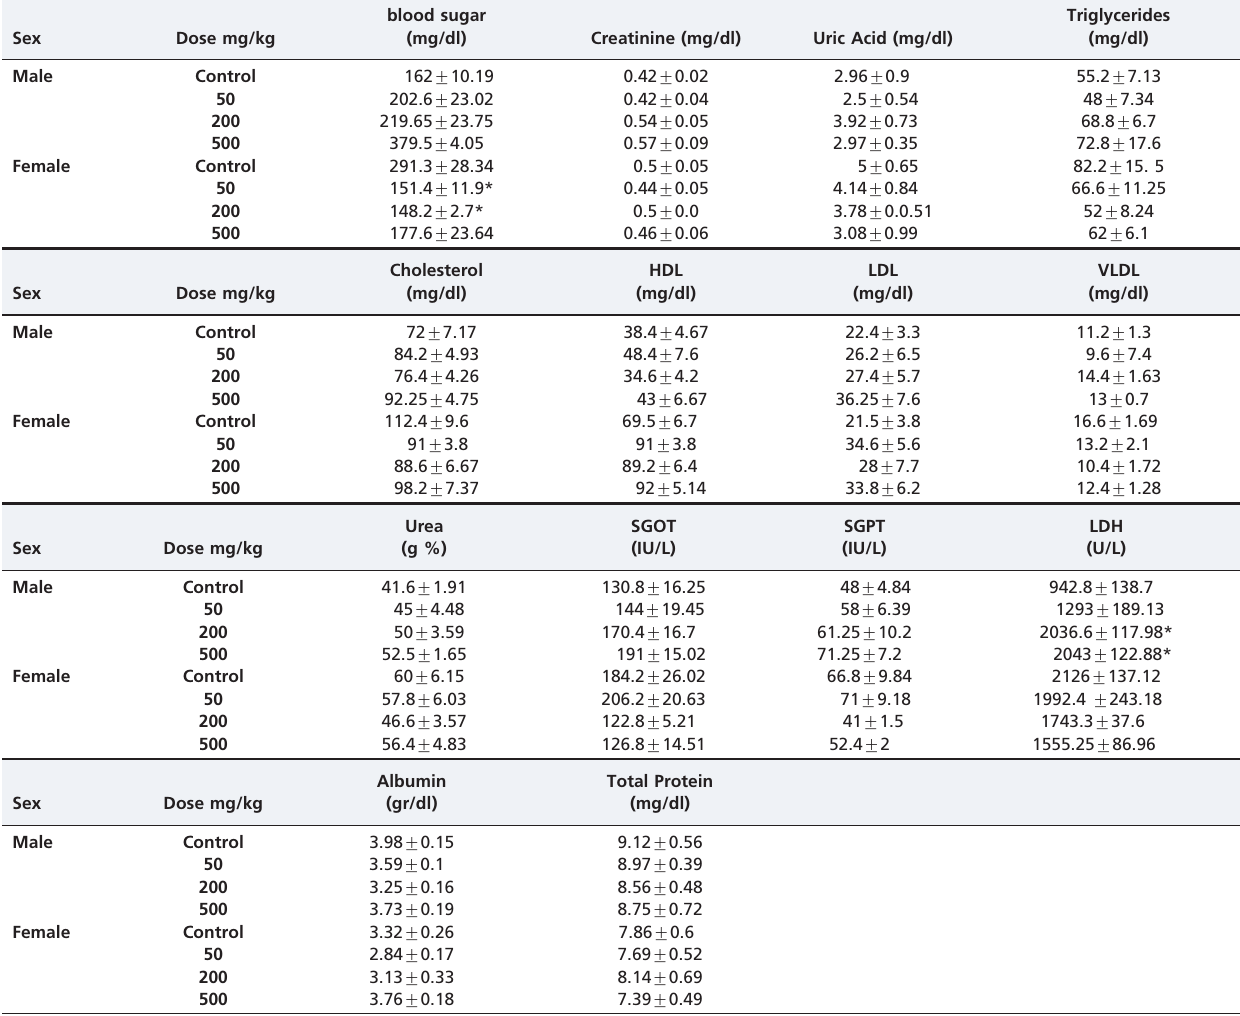
Table 2 - Biochemical parameters of Wistar rats after 45 days treatment with E.platyloba.